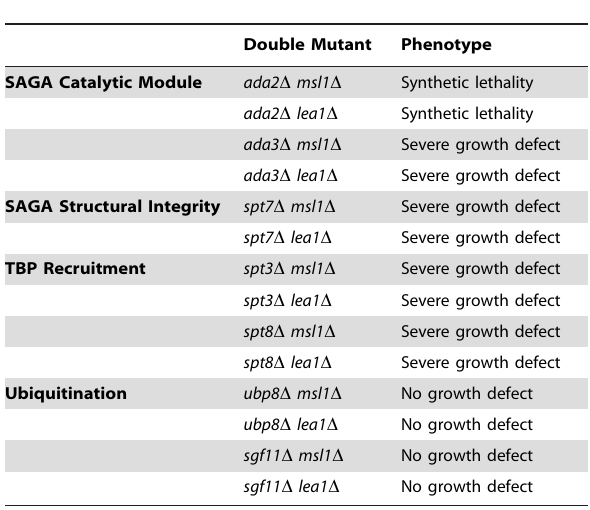
Table 1. Summary of genetic interactions between U2 snRNP factors, Msl1/Lea1, and SAGA